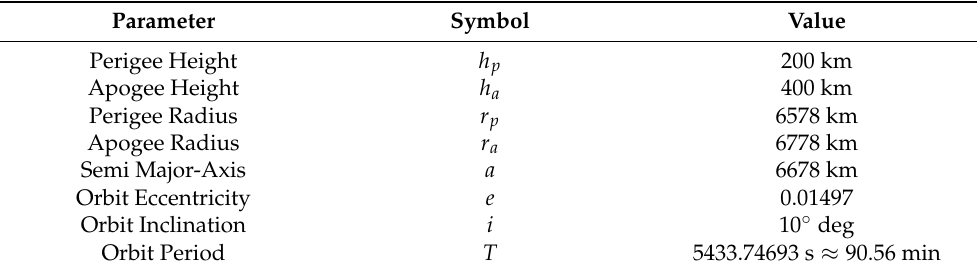
Table 1. Orbital elements for case 1: satellite orbit.